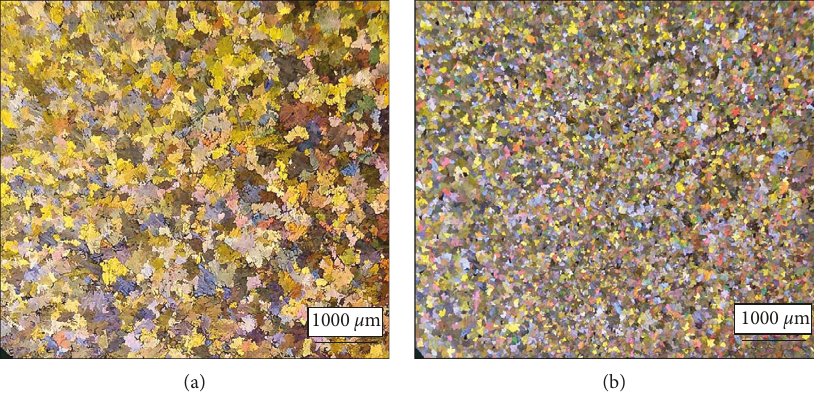
Figure 6: Macrostructures of (a) D0-based alloy and (b) D0+5%Ce+ 0.15%Ti